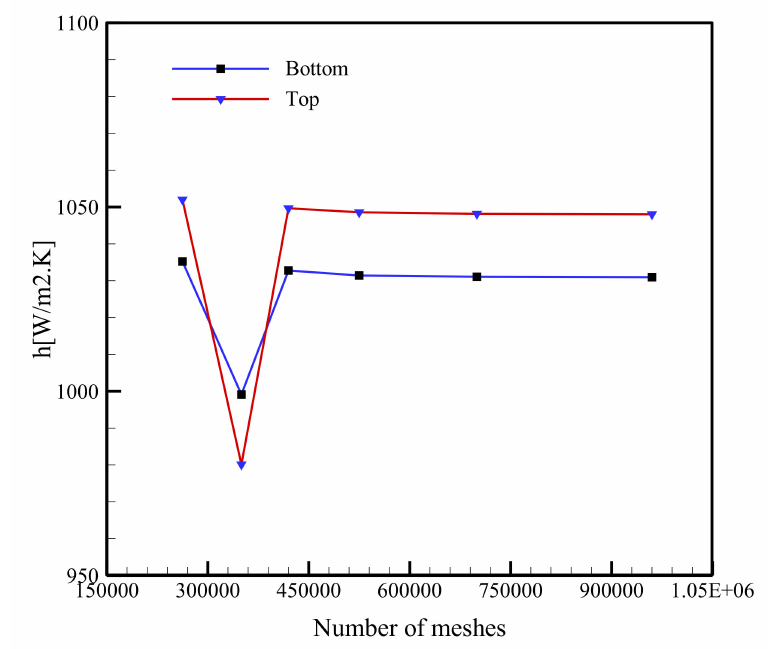
Figure 3. The heat transfer coe ffi cient (HTC) value calculated at di ff erent mesh numbers.